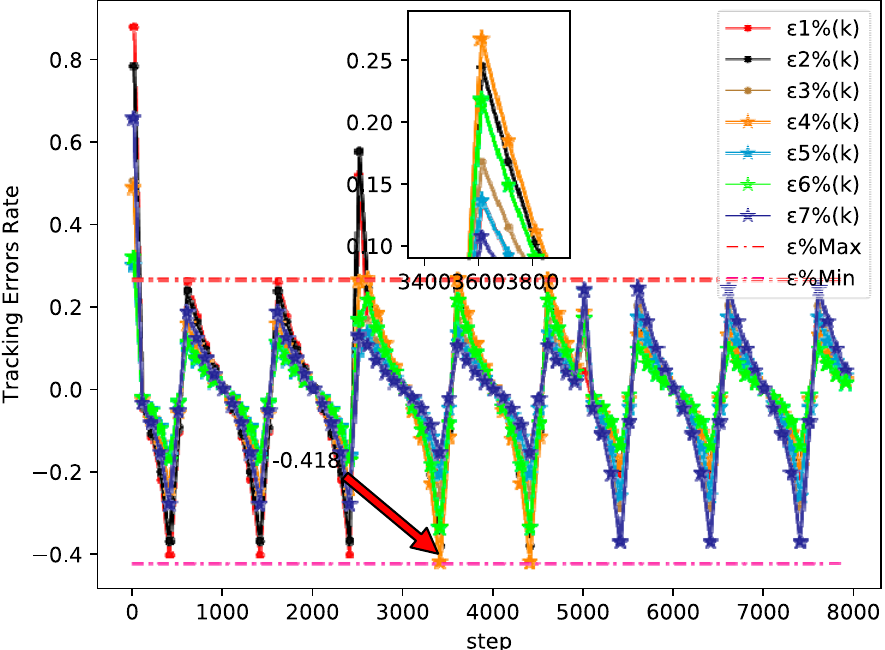
Figure 9. Tracking errors rate of each agent at 500 = Ψ (example 2).